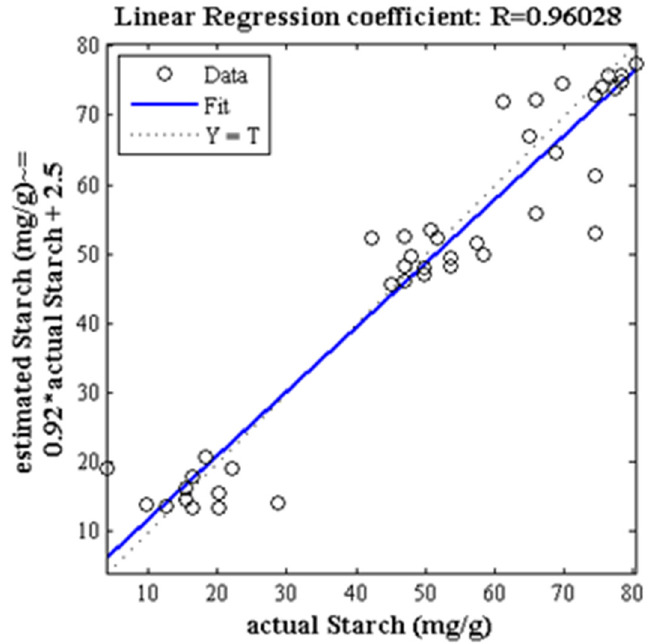
Figure 7. Regression analysis of the scatter plot between the mean estimated and the measured starch